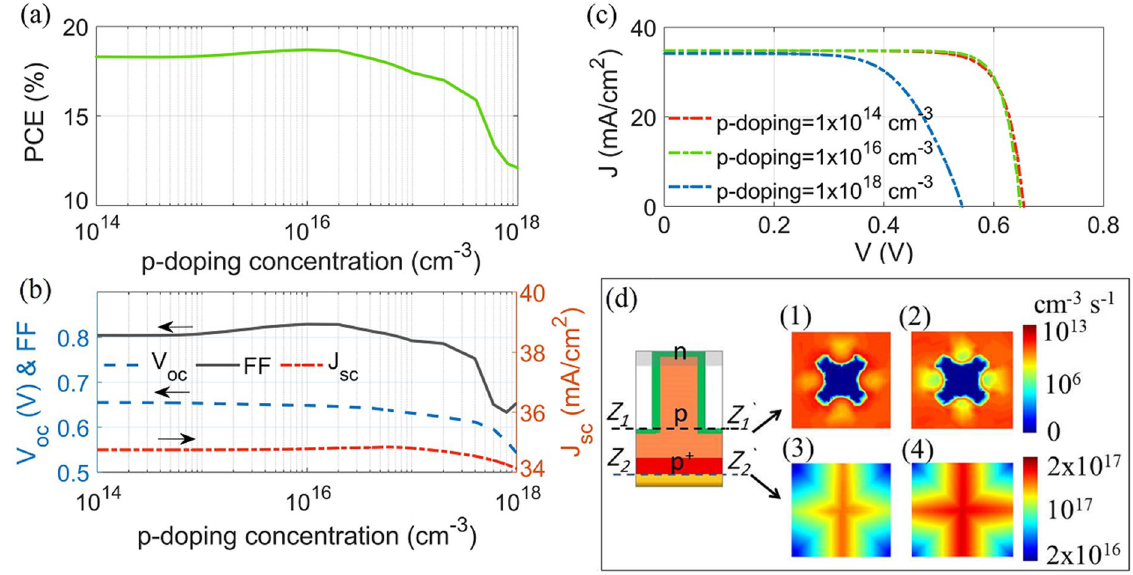
Figure 7. ( a ) PCE, ( b ) V oc , FF, and J sc versus the p-doped layer. ( c ) J–V characteristics, and ( d ) SR rate over NW sidewalls at NW-substrate interface (Z1–Z1 ′ ) at p-doping (1) 1 × 10 16 cm corresponding SR rate at BSF-metal interface (Z2–Z2 ′ ) is at (3) and (4). This image is created by Lumerical 2020a, FDTD Solver Version 8.23.2305, https:// www. lumer ical. com (license number-12802) released to Zewail City of Science and Technology, Giza,